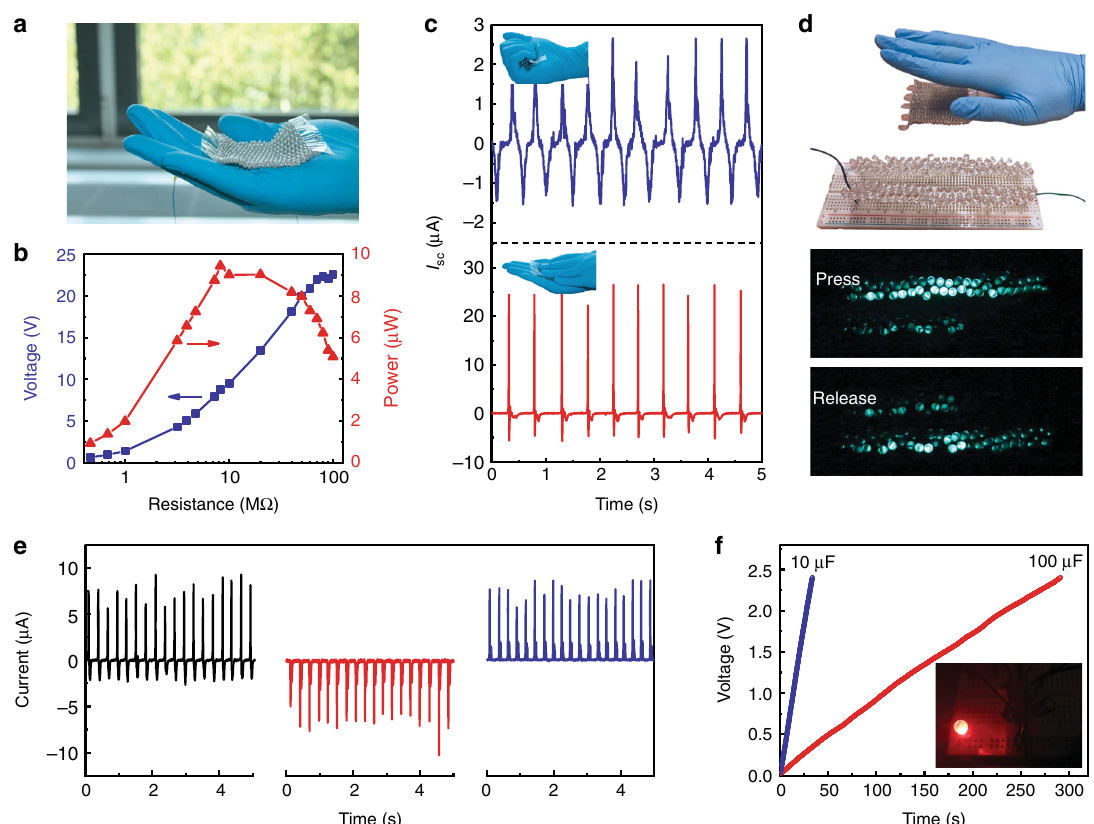
Fig. 3 Energy-harvesting performance of triboelectric textiles. a Photograph showing that a continuous and long triboelectric fi ber was woven into a textile. b Dependence of the output signals on the resistance of external loads. c I sc waveforms of the textile triggered by mechanical stimuli: hand grasping (upper part) and hand tapping (bottom part). d Demonstration of 100 LEDs lighted up by the textile under tapping. The connection of the LED arrays is schematically shown in Supplementary Fig. 12. e The output current of the textile before and after being recti fi ed by a bridge recti fi er. f Charging curves of two different capacitors connected to the textile. The inset shows that a red LED can be continuously lighted up by a charged